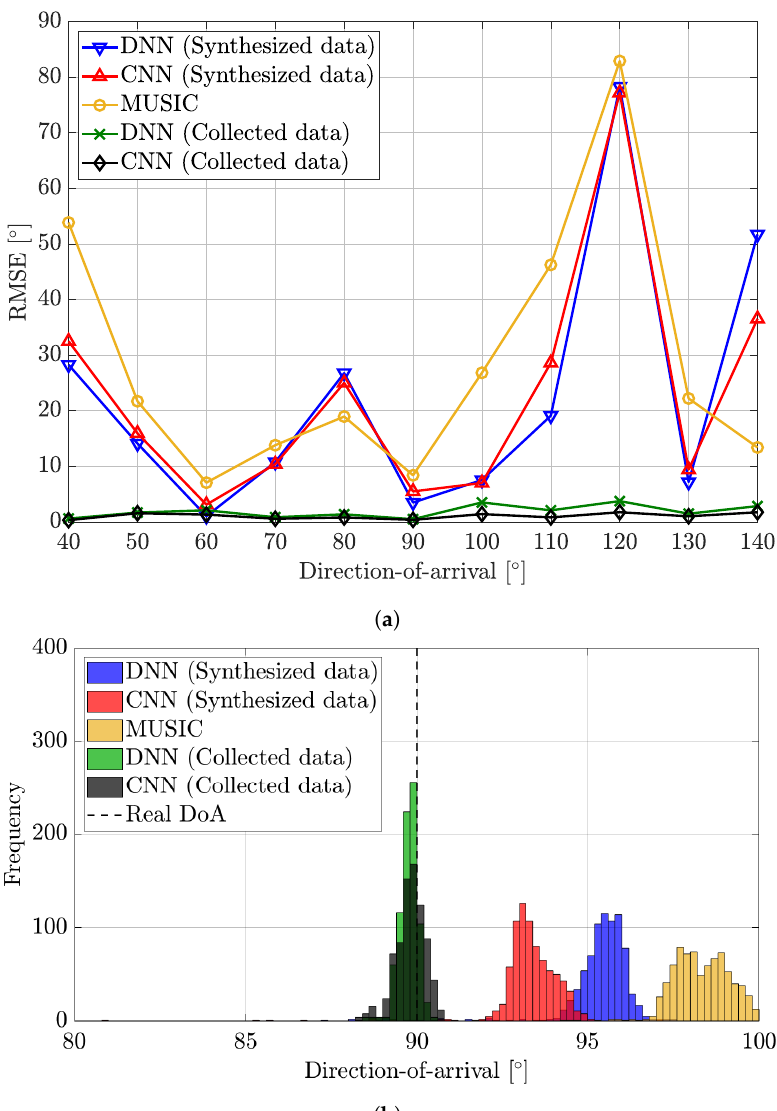
Figure 5. Performance analysis of DoA estimation algorithms in the indoor environment. The first figure shows the RMSE according to DoA, and the second figure is a histogram of estimation results when the actual DoA is 90 ◦ . ( a ) RMSE. ( b )